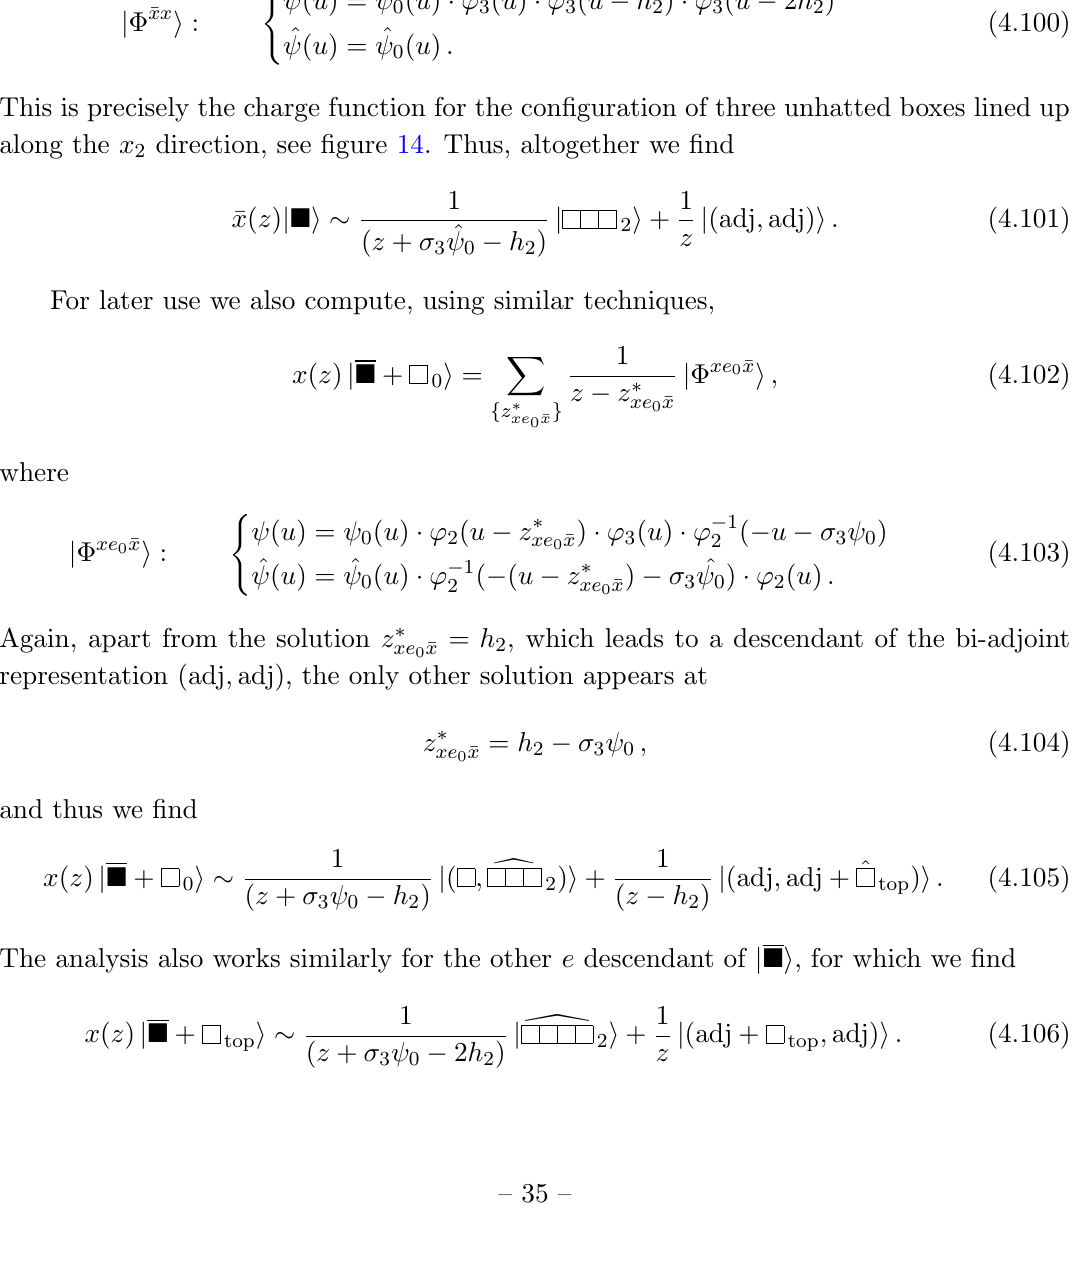
Figure 14 . The con(cid:12)guration leading